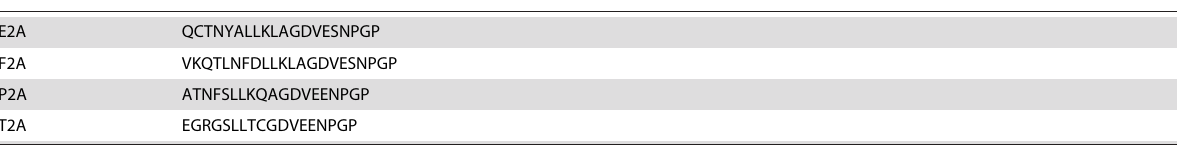
Table 2. 2A peptide